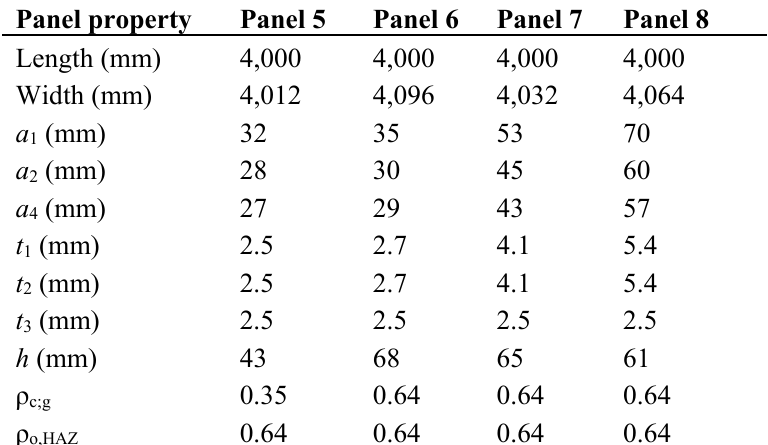
Table 10. Dimensions of optimized Shear Panels 5 to